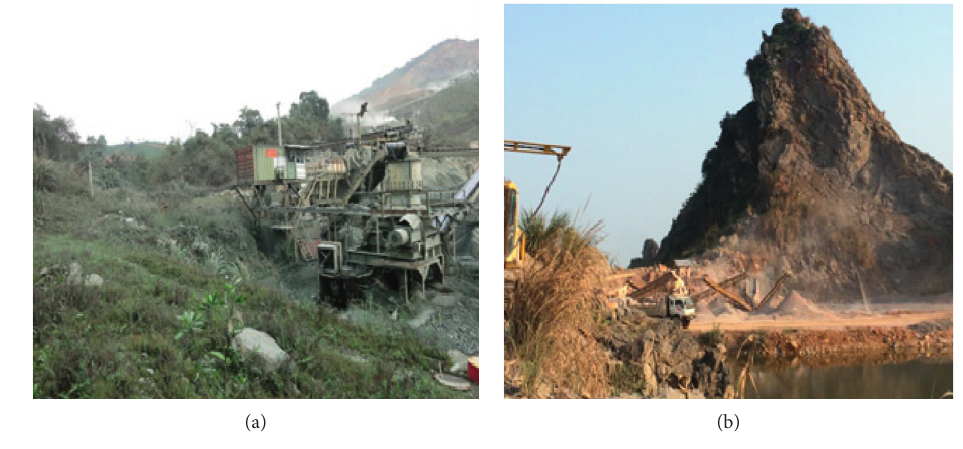
Figure 4: Sampling point in production area.